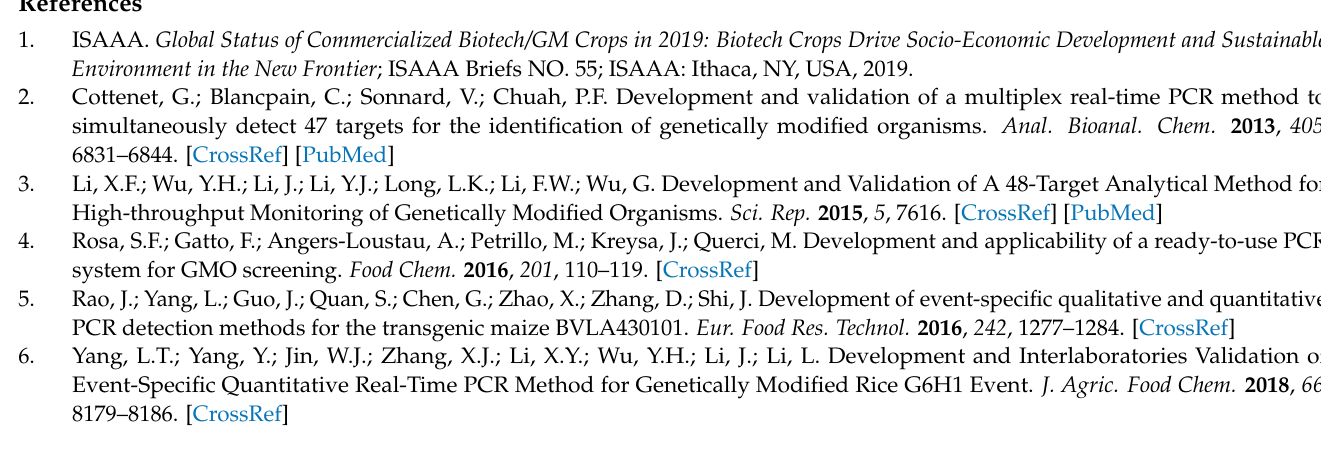
Figure S7: Agarose gel electrophoresis of RPA products at various reaction temperatures; Figure S8: Agarose gel electrophoresis of RPA products from various primer concentrations; Figure S9: Agarose gel electrophoresis of RPA products at various reaction time; Figure S10. The real-time PCR amplified curves from maize Ruifeng 12-5 at different